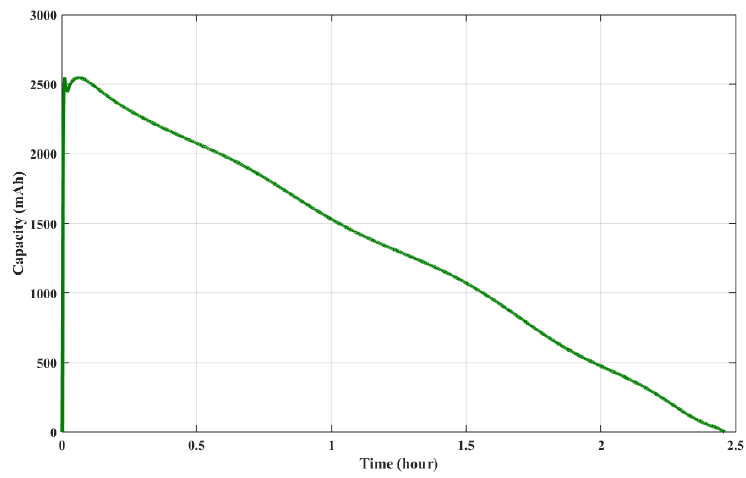
Figure 10. Estimated remaining capacity of battery. Table 2. CPU time comparison of the proposed and other methodologies.